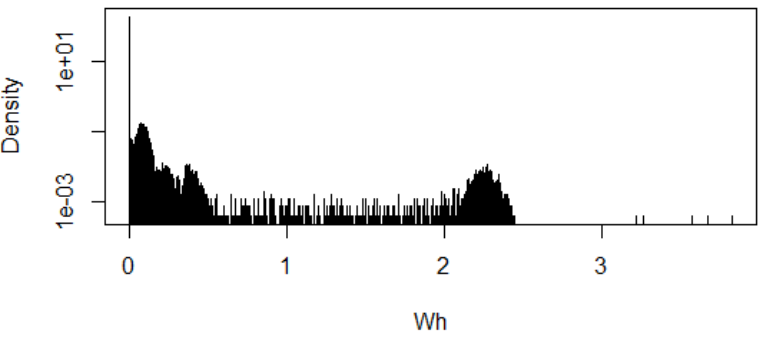
Figure 7. Density of the data.